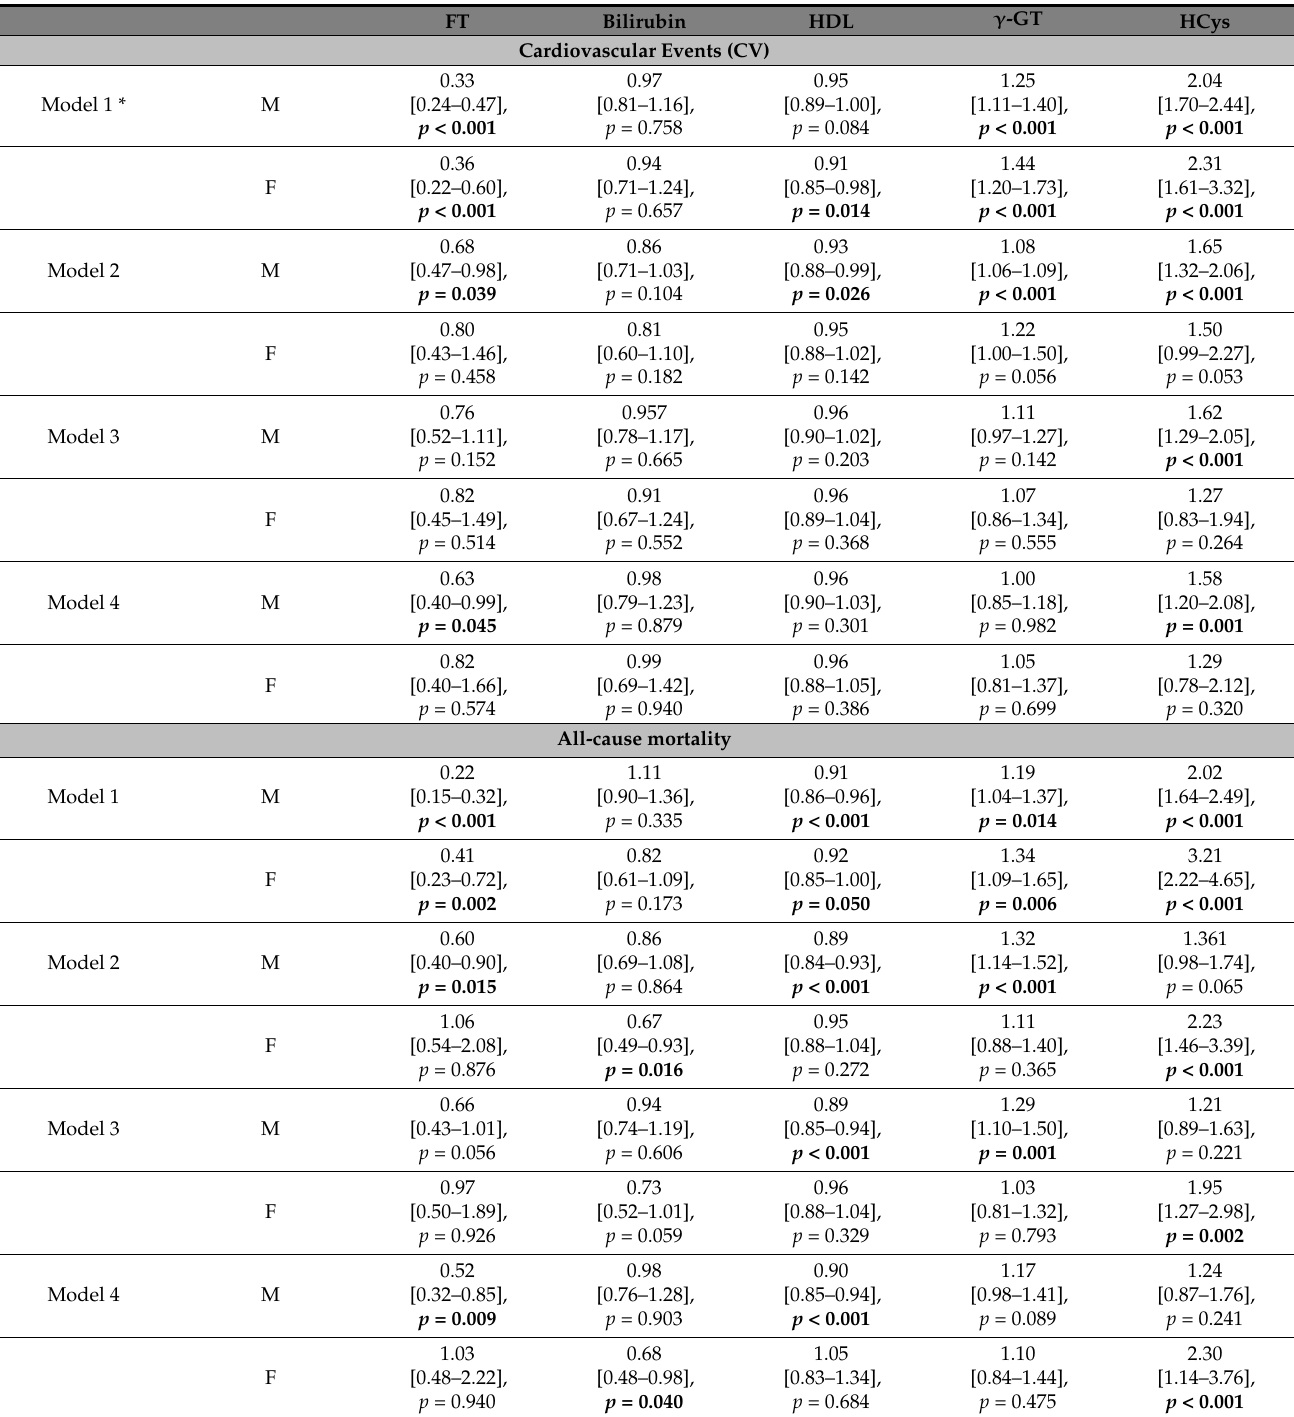
* Model 1, crude model. Model 2, Model 1 with adjustment for age. Model 3, Model 2 with adjustment for history of diabetes, systolic blood pressure, BMI, total cholesterol, and current smoking. Model 4, Model 3 with adjustment for hs-CRP. Bold p -values indicate statistical significance. Abbreviations: HCys, homocysteine; HDL, high-density lipoprotein; HR, hazard ratio; FT, free thiols; γ -GT, gamma-glutamyl